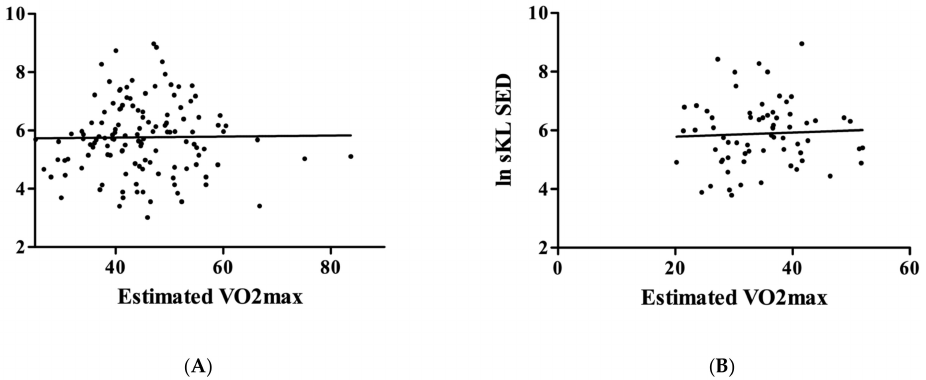
Figure 2. The relationship between Gripmax and KL. The maximal hand grip force showed a significant relationship in the TRND group (Panel ( A ), N = 131), but not in the SED group (Panel ( B ), N = 71).